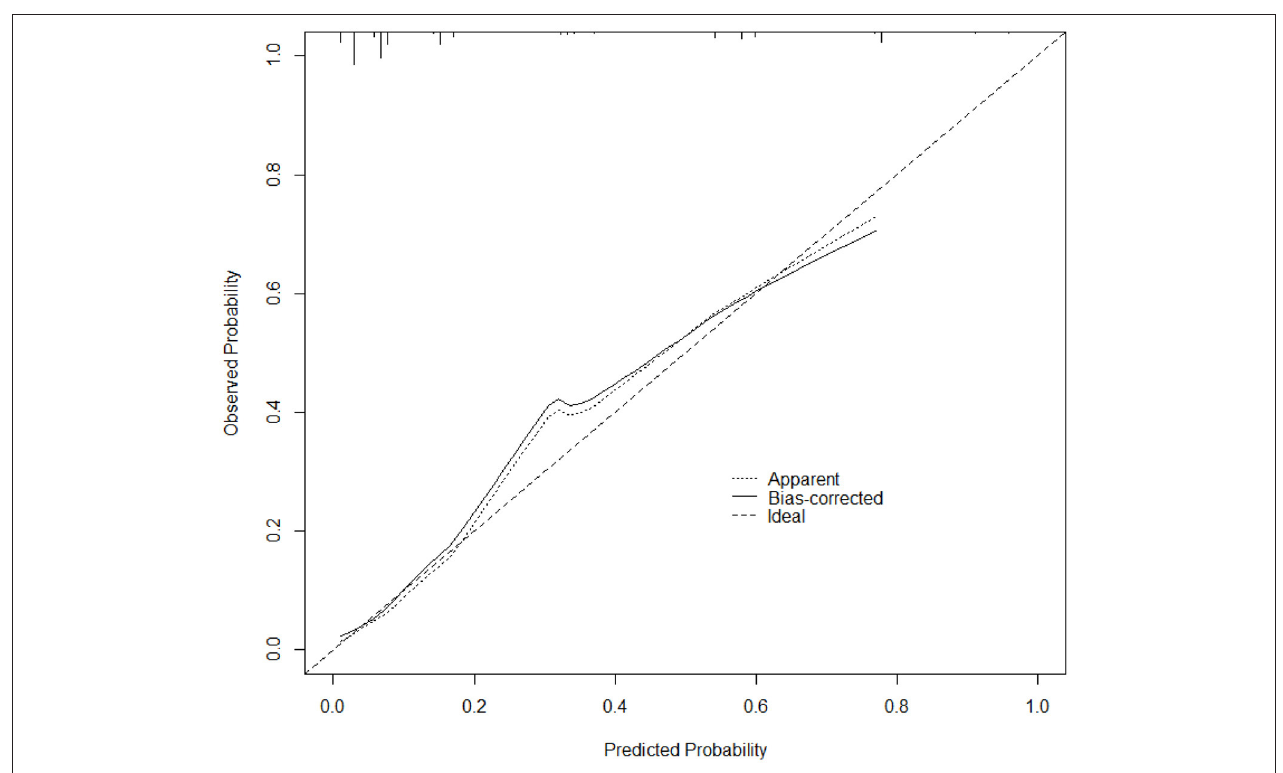
FIGURE 4 | Calibration curve of the nomogram prediction model for IE. The x -axis depicts the predicted probability of dying during hospitalization, whereas the y-axis depicts the observed probability of dying during hospitalization.